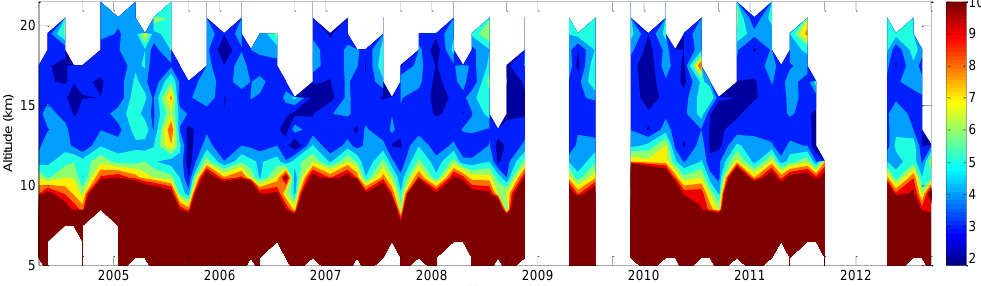
Figure 2. Time series of the MAESTRO monthly mean water vapour volume mixing ratio (VMR) vs. altitude (5.5–22.5km) at southern high latitudes (60–90 ◦ S) with a linear colour scale (ppm), emphasizing the stratospheric variability. Unlabelled ticks along the bottom correspond to September. The time series is composed using the 8 months in which ACE samples the southern high latitudes (see Sect. 2.4).